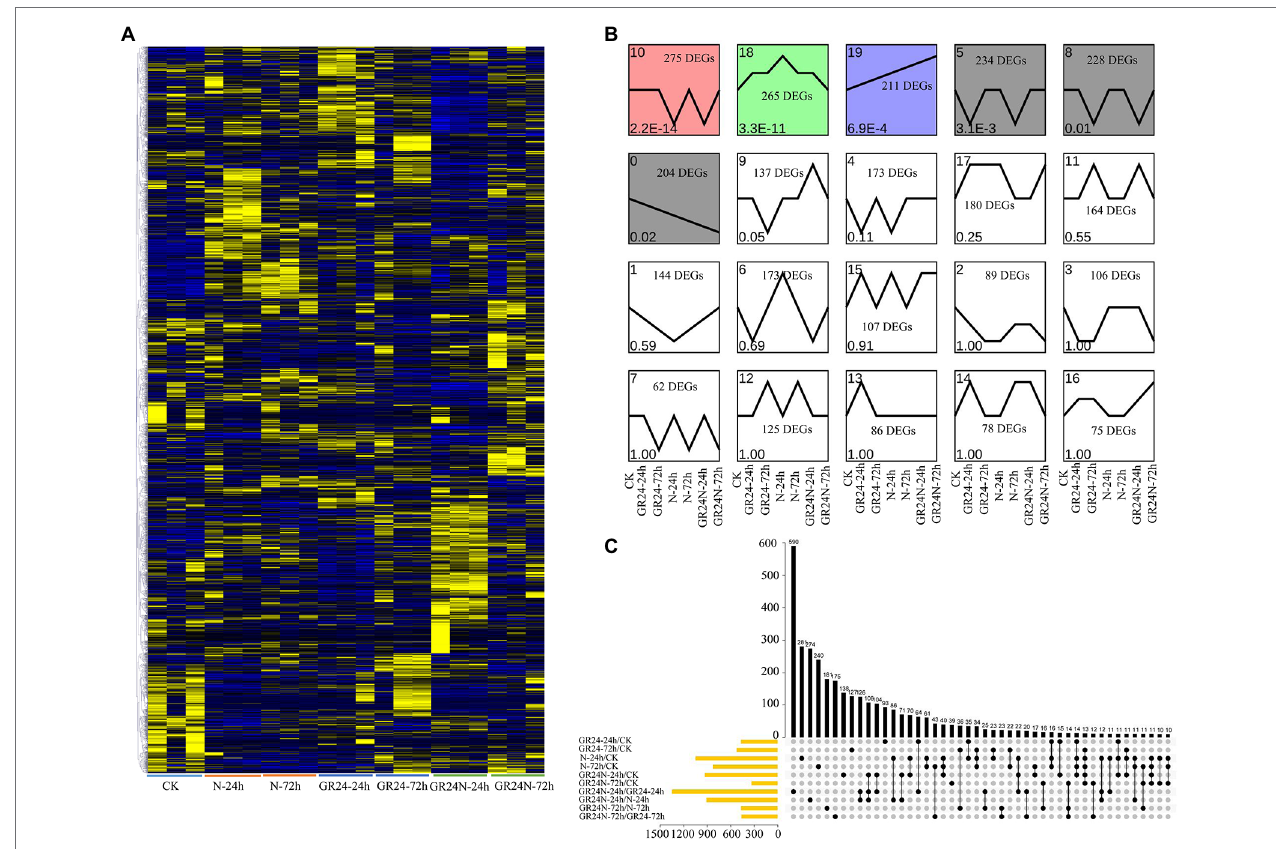
FIGURE 1 | Identification of the DEGs between additional N deposition and GR24 treatments in Torreya grandis. (A) Expression profiles of the DEGs under additional N deposition or GR24 treatments were shown by a heatmap. The original expression values were normalized by Z-score normalization. (B) DEGs module expression trends by the line chart. The expression trend line graph of each sub-module, the horizontal axis is the sample, and the vertical axis is the average expression level of all the genes in the sample. The trend of value of p < 0.05 is significant. (C) Upset plot of the DEGs in different